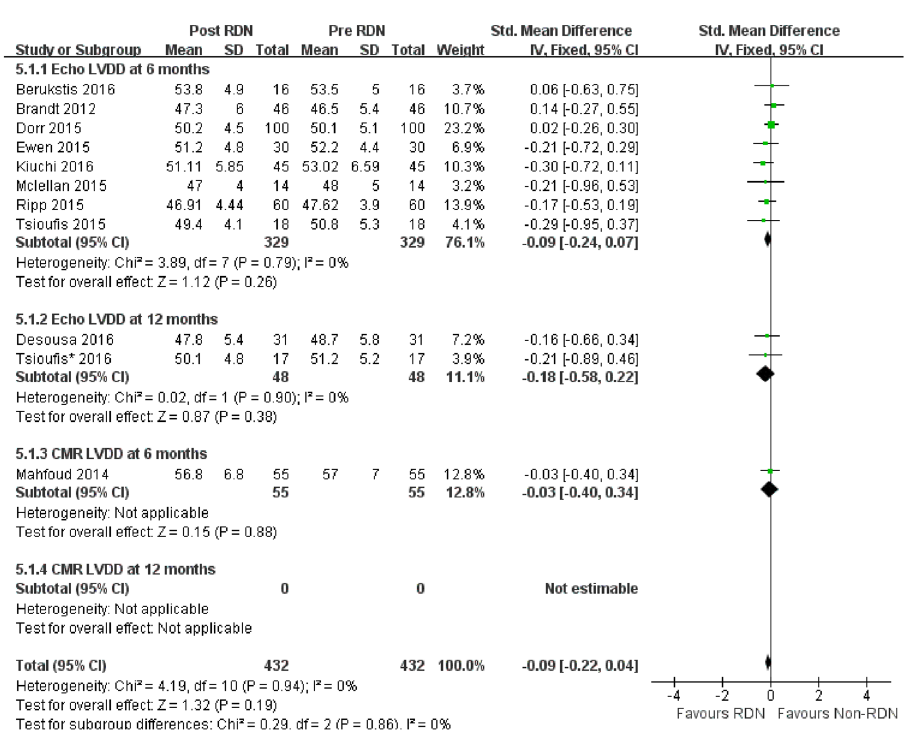
Figure 3. Forest plot of RDN changing LAVI ( A ) and E/e’ ( B ) at 12 months in randomized controlled trials.